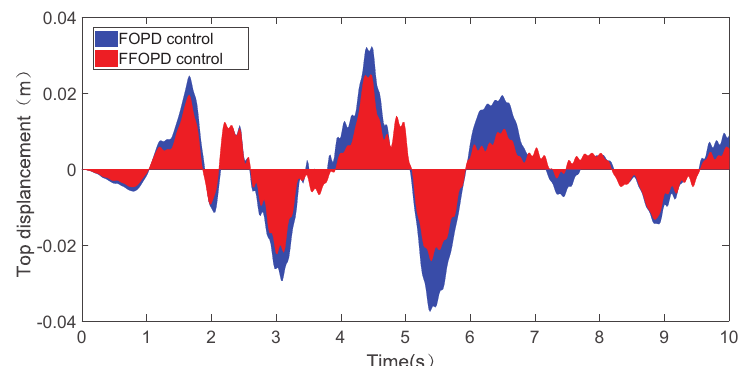
Figure 14. Top floor displacement curve under Taft earthquake.